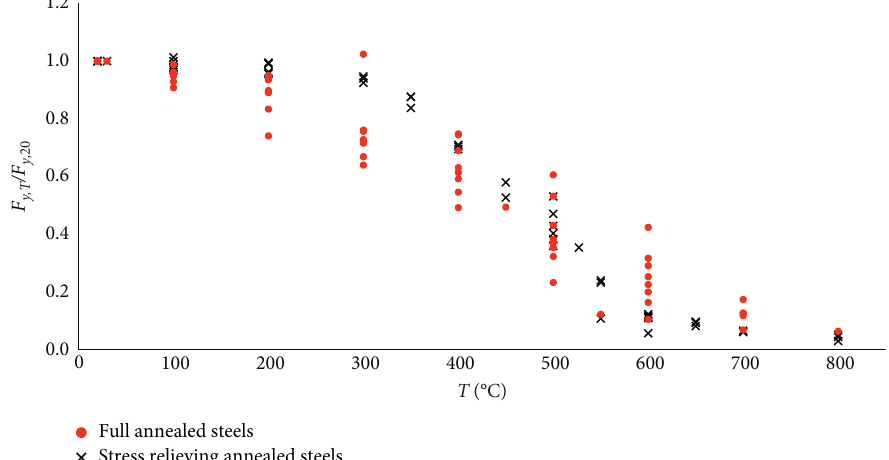
Figure 19: Comparison of the retention factors of yield strength for cold-rolled thin-walled steels according to test results with available research results.